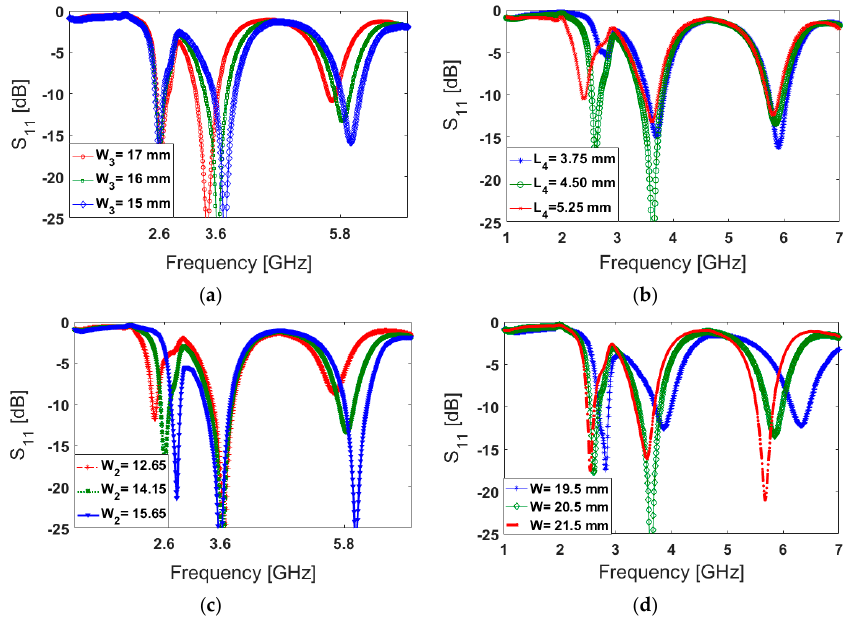
Figure 4. The S 11 characteristics for different sizes of ( a ) W 3 , ( b ) L 4 , ( c ) W 2 , and ( d ) W.